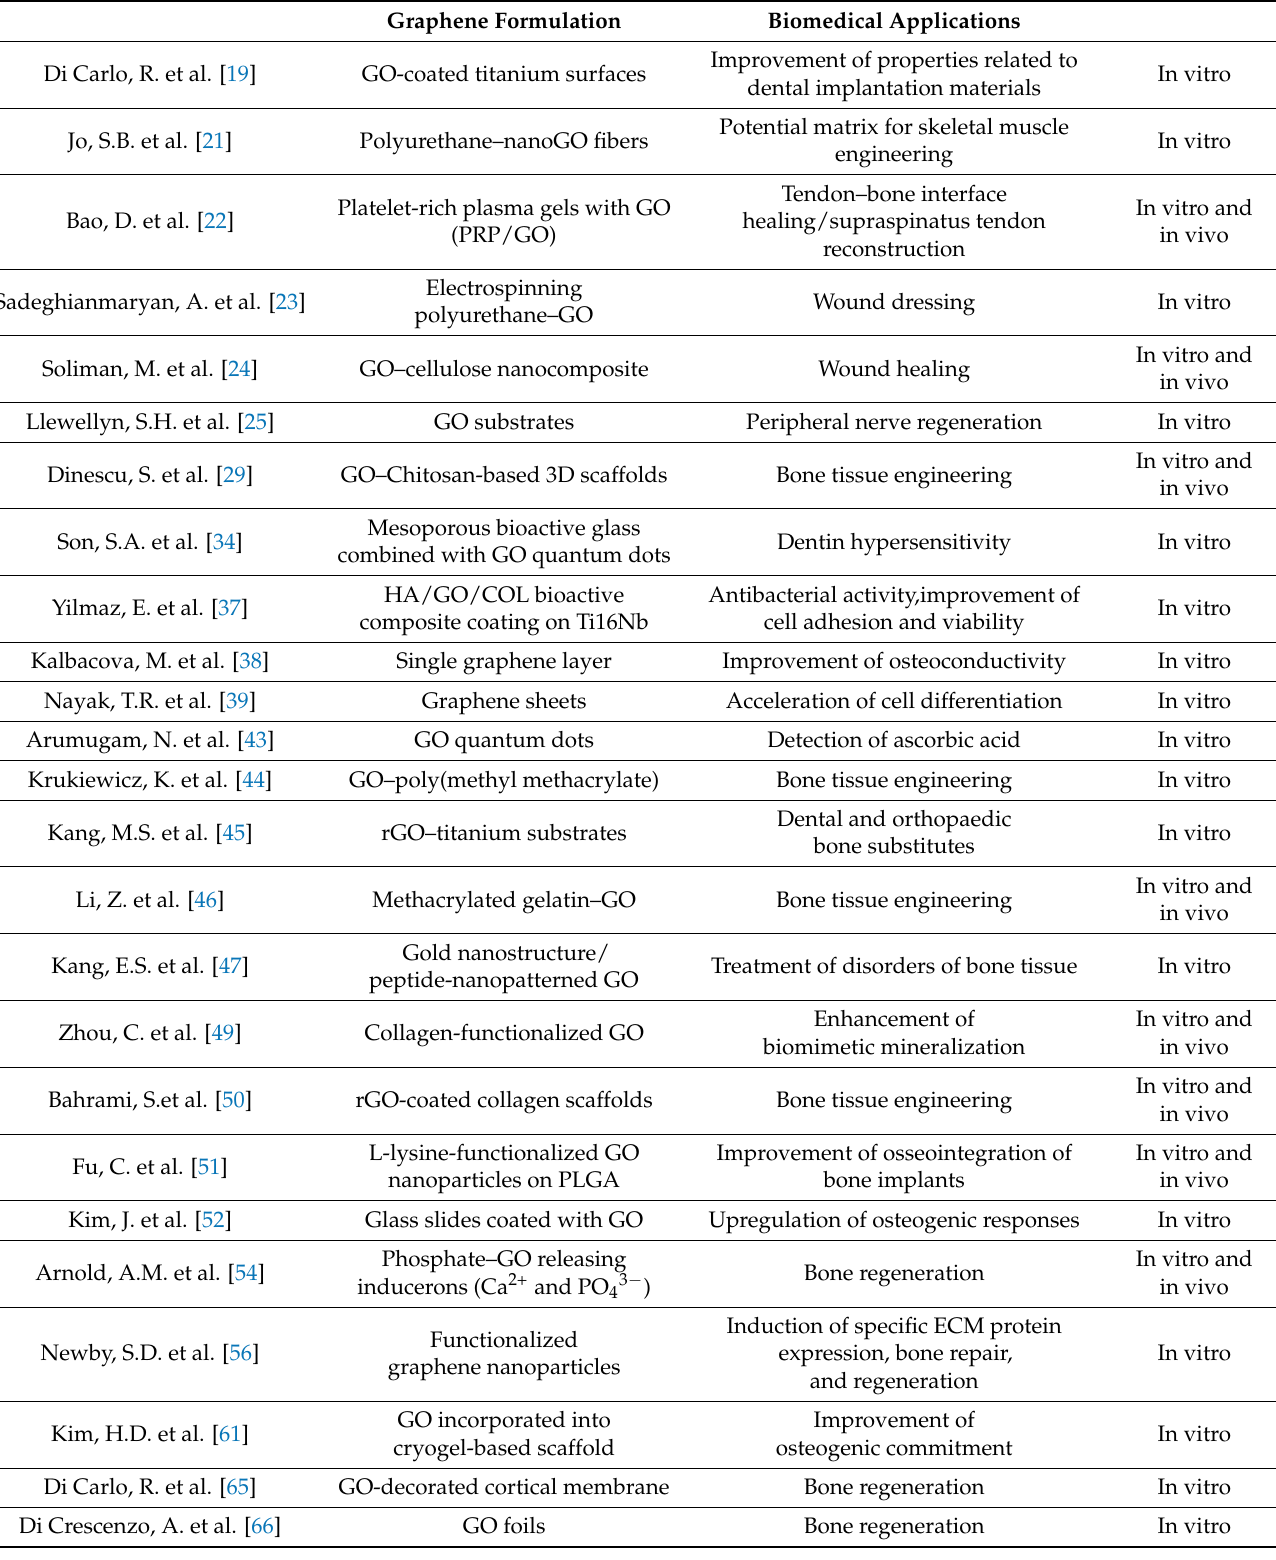
Table 2. Biomedical applications of GO. The table summarizes in vitro and in vivo studies related to GO and